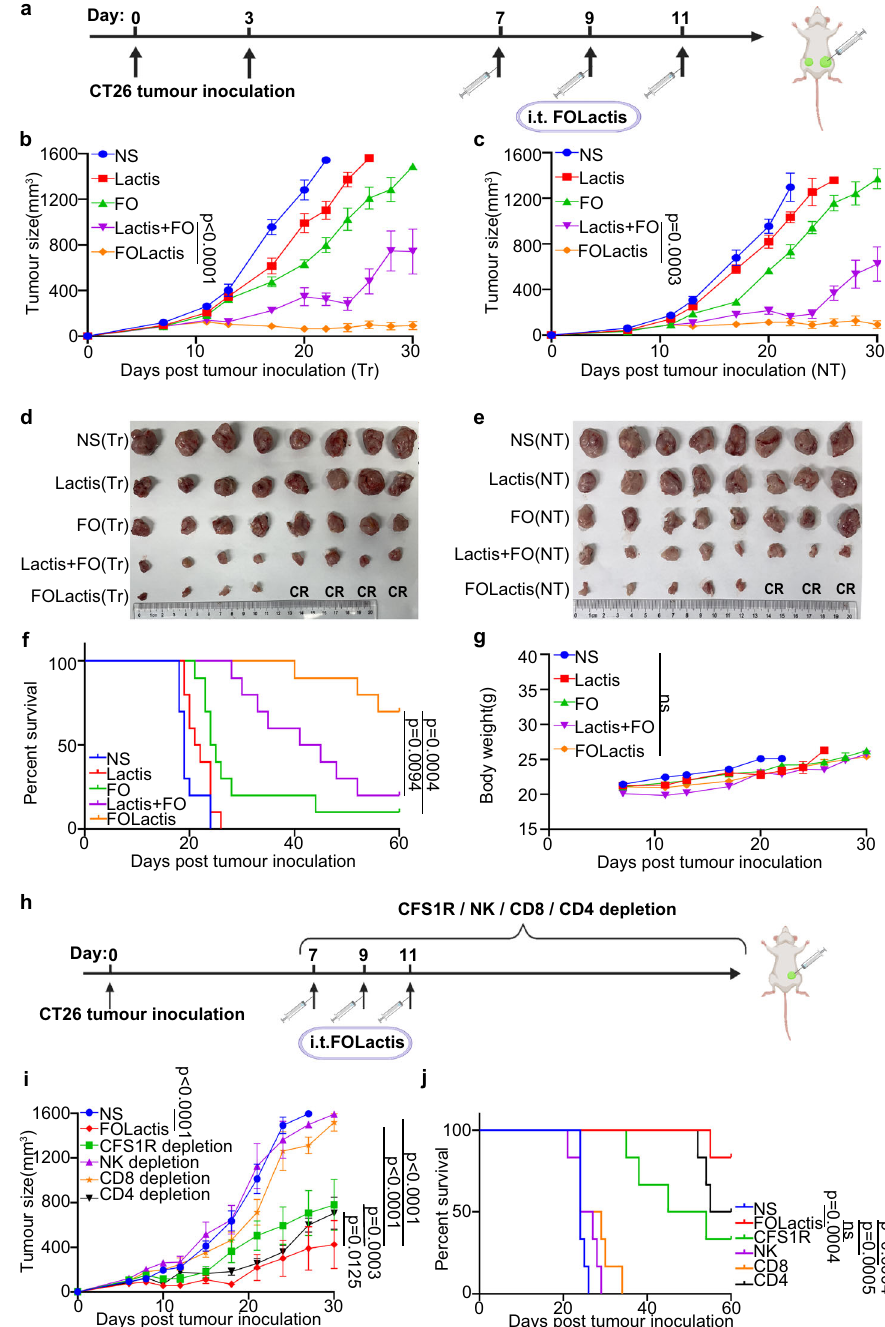
Fig. 4 | ISV with FOLactis potently inhibited the treated and untreated tumor growth simultaneously in a model ofColonCancer. a Schematic diagram of the treatmentinmaleCT26tumor-bearingmice.CreatedwithBioRender.com.Average tumor-growthcurves( b :Treatedtumors(Tr). c :Nontreatedtumors(NT).)ofBALB/ cmicebearingCT26colontumorwithdifferenttreatmentsasindicated( n =8).The mice were administered with NS, 10 9 CFU Lactis, 50 μ g FO, 10 9 CFU Lactis + 50 μ g FO, and 10 9 CFU FOLactis dissolved in NS to a fi nal volume of 100 μ l per dose intratumourally on days 7, 9, and 11. The tumor size was measured every 2-3 days from the fi rst day of administration. d , e Photos of tumors harvested from mice in all groups on day 26 after tumor inoculation ( n =8). CR: complete response. f Survival curves of BALB/c mice in different groups for 60 days ( n =10). P -values were calculated by log-rank (Mantel – Cox) test. ns represented p >0.05. g Average weight of different groups for 30 days ( n =8). The error bars represented mean ± s.e.m. p -values were calculated by two-tailed unpaired Student ’ s t-tests. ns